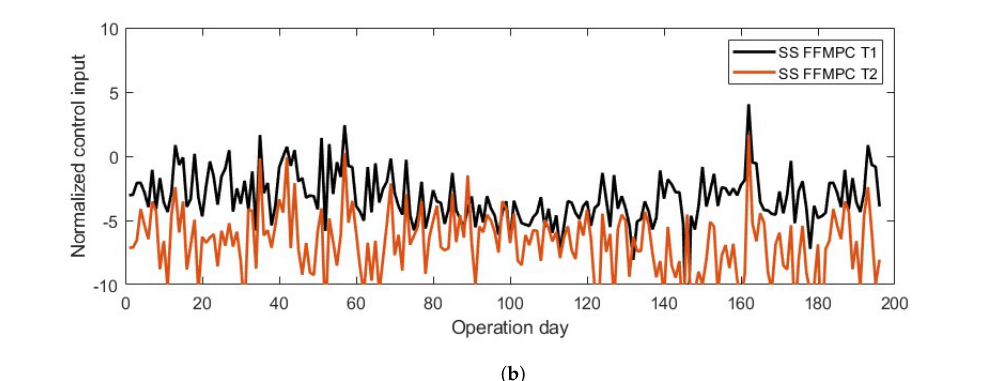
Figure 9. Diesel quality and reactor temperatures estimated with the state space model. ( a ) Diesel T95 estimations. ( b ) Suggested reactor temperatures.